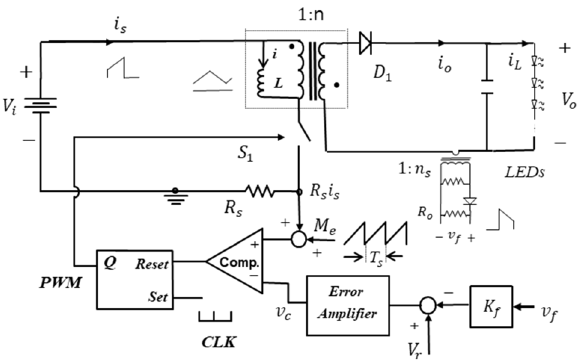
Figure 1. Constant-frequency CMC flyback LED driver with stabilization ramp.